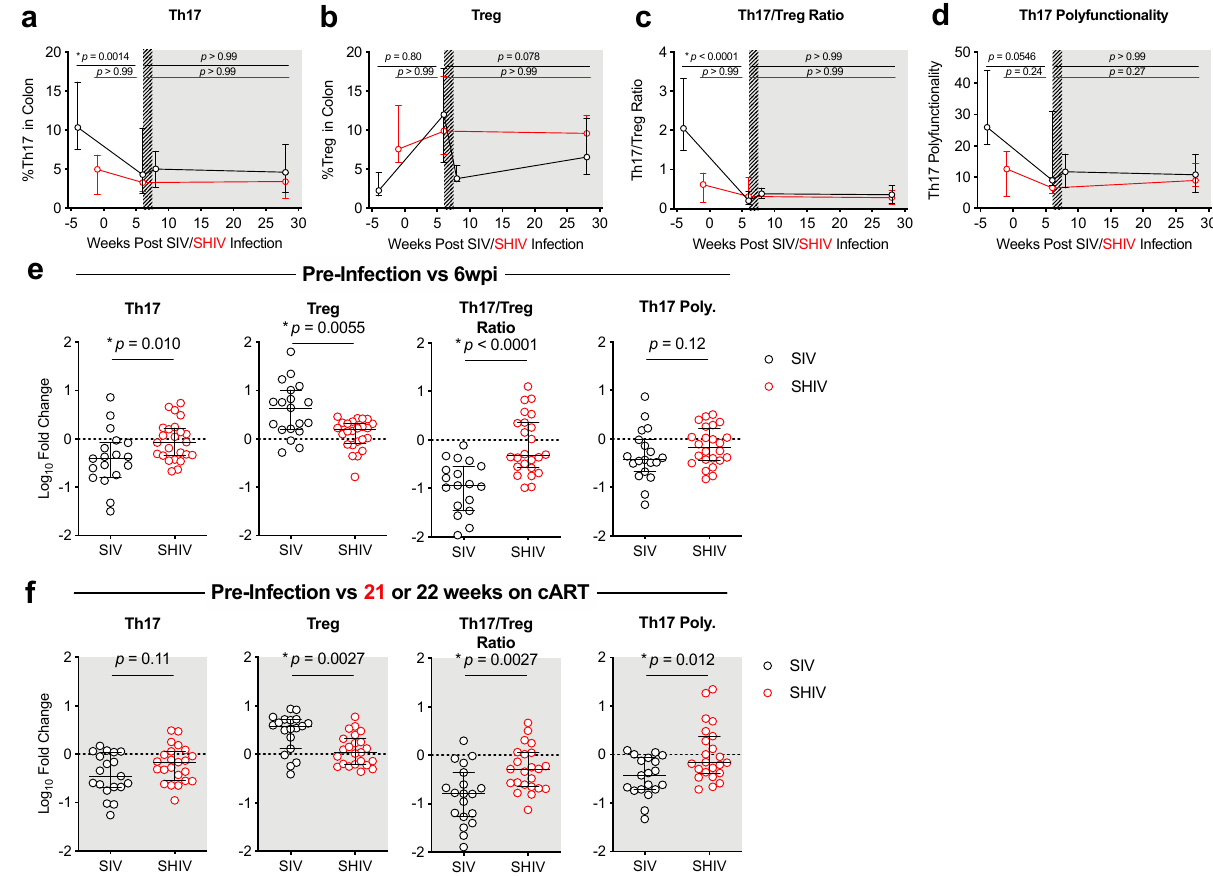
Figure 4. Higher viral burden during acute SIV infection and during cART is associated with greater gut dysfunction. ( a , b ) The percentage of Th17 (IL-17 + ) ( a ), stimulated with PMA and ionomycin, or unstimulated Tregs (FoxP3 + CD25 + ) ( b ) of CD4 + T-cells in the colon was determined by flow cytometry (as described in methods). (c) The Th17/Treg ratio was determined by dividing the percentage of IL-17 + of CD4 + cells by the percentage of FoxP3 + CD25 + of CD4 + cells. ( d ) Polyfunctional Th17 (Th17 Poly.) cells were identified as the percentage IL-17 + cells that produced at least two additional cytokines (IL-22, IFN γ , TNF α , or IL-2) as determined by Boolean gating following in vitro stimulation with PMA and ionomycin. ( a – d ) Hashed and shaded regions indicate periods of cART treatment for SIV RMs and all animals, respectively. Lines indicate medians with interquartile ranges. Kruskal–Wallis test, adjusted p -values are given. ( e – f ) Log 10 -fold change in cells in the colon between pre-infection and acute infection or 21–22 weeks (>5 months) on cART between SIV (black open circles) and SHIV (red open circles). Each dot represents an individual RM with medians and interquartile ranges indicated. The dotted line indicates no change (value of 1). p -values were determined using a Mann–Whitney test, with * p -values ≤ 0.05 considered significant.